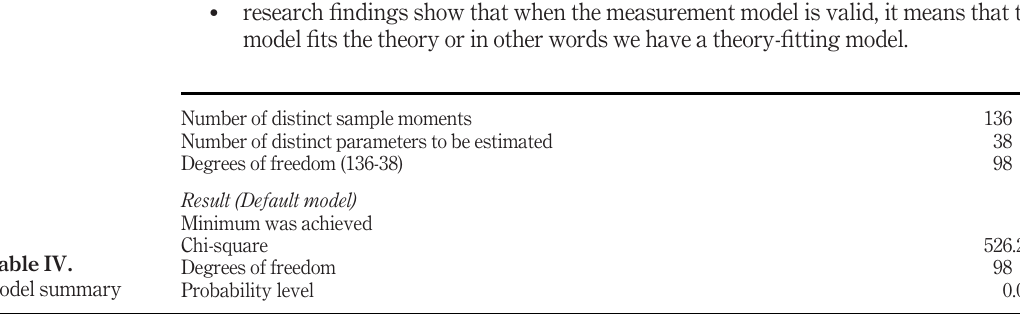
Table IV. Model summary